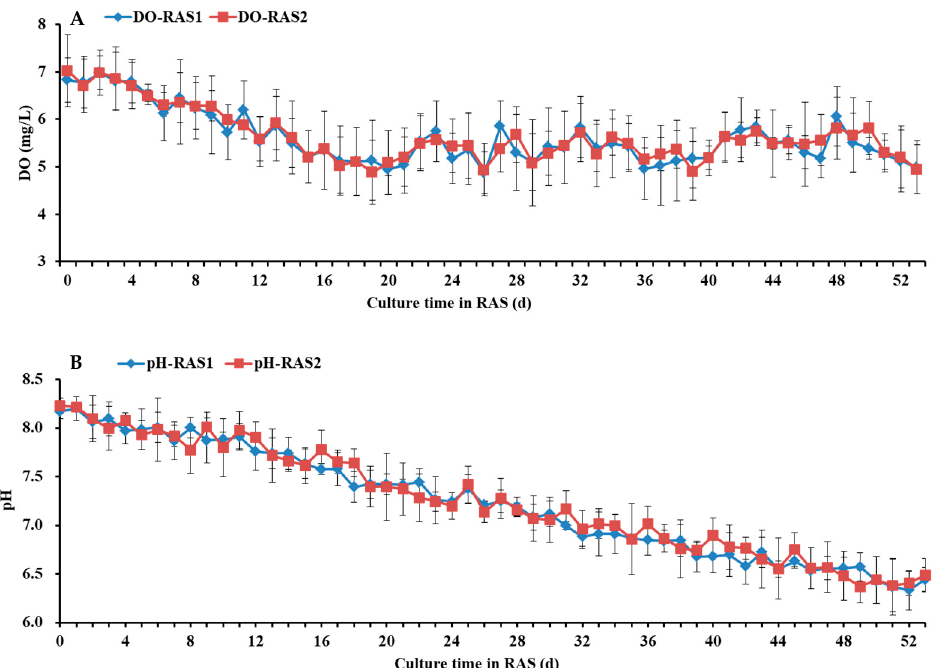
Figure 6. Changes in pH ( A ) and DO ( B ) in the culture tanks during the recirculating aquaculture period (means ± SE, n = 3).